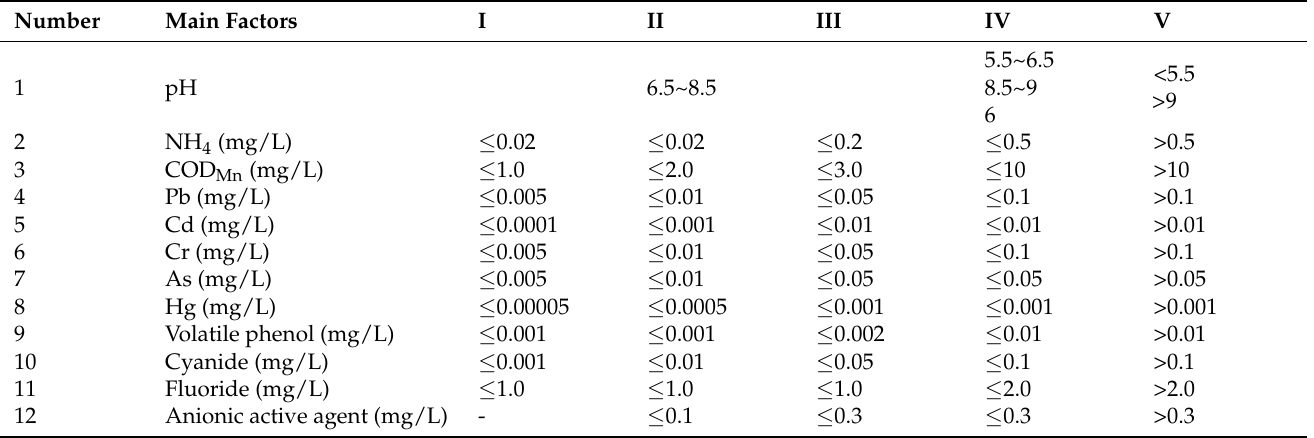
Table 3. Limits for the standard items of the environmental quality standards for surface water.